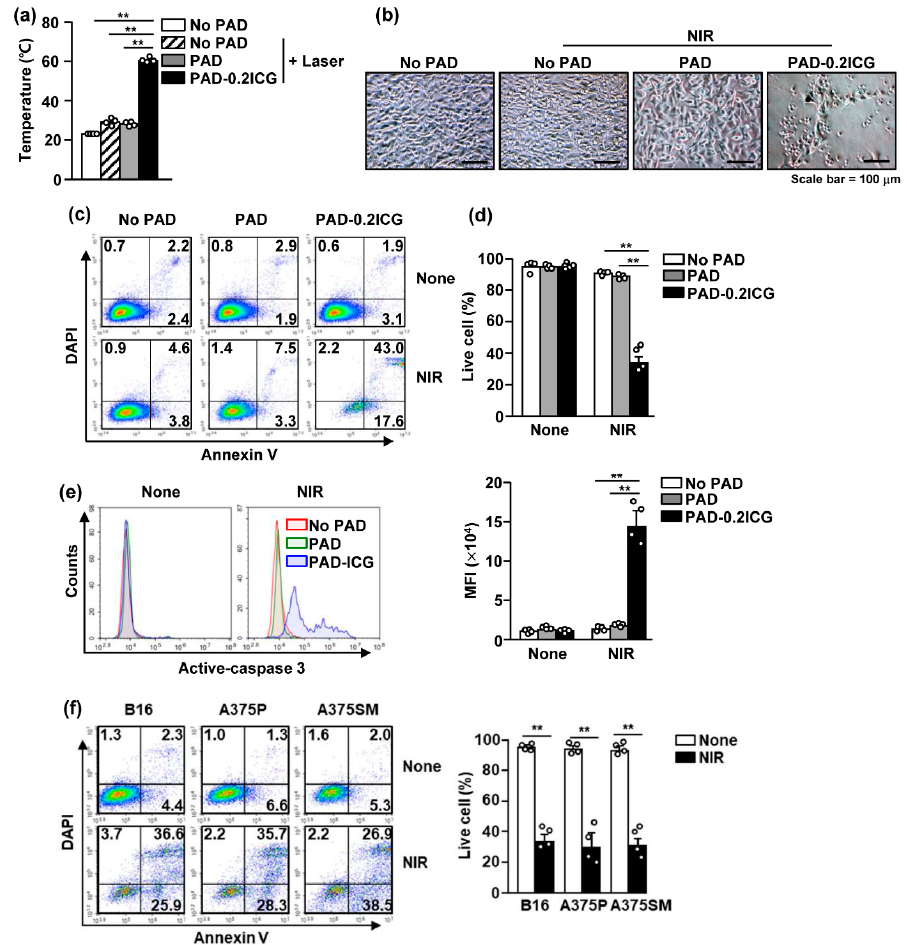
Figure 3. In vitro photothermal therapy (PTT) by PAD-ICG hydrogel against melanoma cells. B16 cells were treated with PAD-0.2ICG and irradiated with near-infrared (NIR) laser (1 W/cm 2 for 5 min): ( a ) the average temperature of pure PAD and PAD-0.2ICG after 808 nm laser irradiation at 1 W/cm 2 for 5 min; ( b ) the cell morphology was shown 24 h after the laser irradiation; ( c ) the cell apoptosis and necrosis were analyzed by annexin-V and 4 ′ ,6-diamidino-2-phenylindole (DAPI) staining; ( d ) the mean percentage of annexin-V - and DAPI - live cells was shown; ( e ) the intracellular active-caspase 3 levels measured by flow cytometry (left panel) and the mean fluorescence intensity (MFI) of active- caspase 3 are shown; and ( f ) B16, A375P and A375SM were treated with PAD-ICG and irradiated with NIR at 1 W/cm 2 for 5 min. The apoptotic and necrotic cells were analyzed by annexin-V and DAPI staining (left panel). Mean live cells were shown (right panel). Data are representative or show the average of four independent samples (two independent experiments performed with n = 2/group, two-way ANOVA, mean ± SEM), ** p < 0.01.